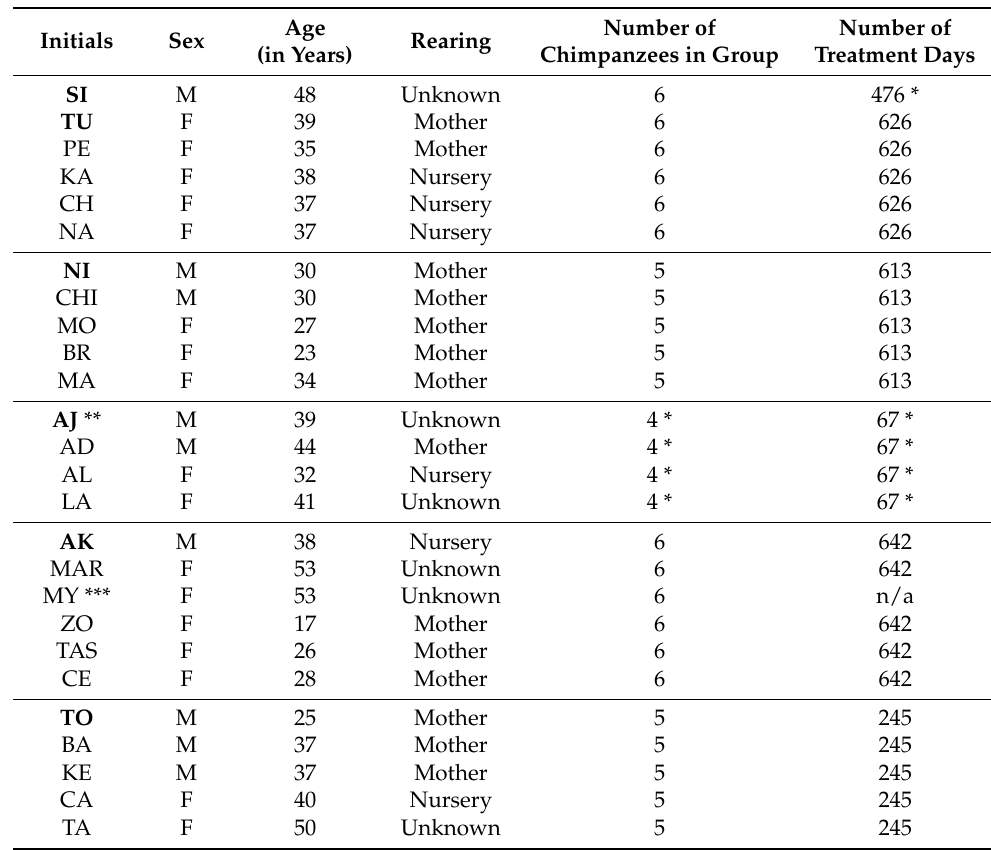
Table 1. Chimpanzee demographic information.